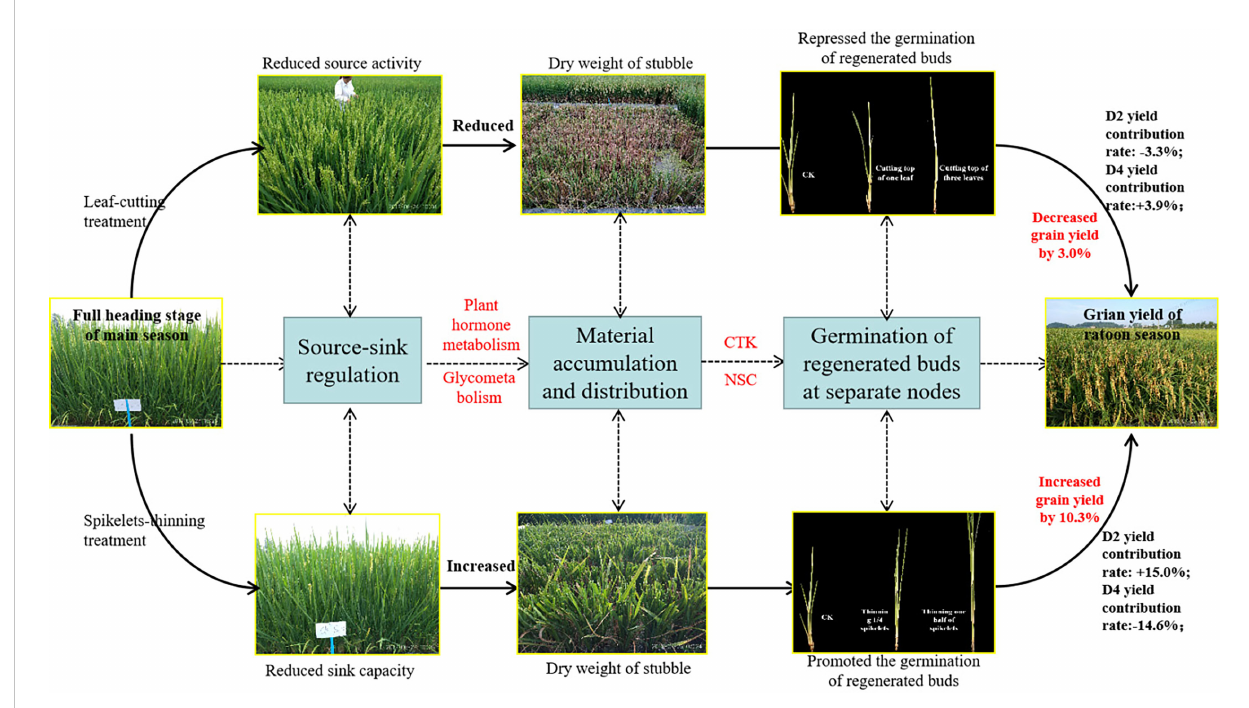
FIGURE 5 Pathway diagram for the effect of leaf-cutting treatment and spikelets-thinning treatment on the grain yield in ratoon